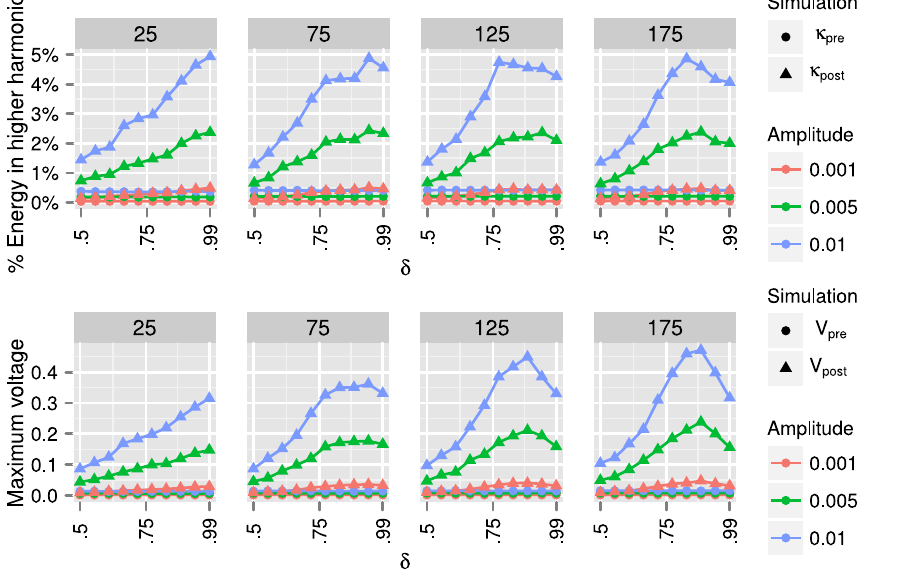
Figure 8. Baraba´si-Albert random graph results. From left to right, we present results for Baraba´si-Albert random graphs with N ~ 25 , 75 , 125 , and 175 nodes. For each graph, we use algorithm (36) to modify the inductances L such that the ratio of the smallest to the second smallest eigenvalue is d . We use pre and post to denote, respectively, the graphs before and after algorithm (36) is applied. By shrinking the gap between the first two eigenvalues, the energy transferred to higher harmonics (37) can be increased from approximately k pre & 0 : 5 % to k post & 5 % (for all graph sizes), and the maximum voltage (38) can be increased from V pre v 0 : 05 volts to V post [ ½ 0 : 3,0 : 5 (cid:2) volts (depending on the graph size). We also note that for larger graphs, choosing d ~ 1 (i.e., no gap between the first two eigenvalues) does not yield optimal